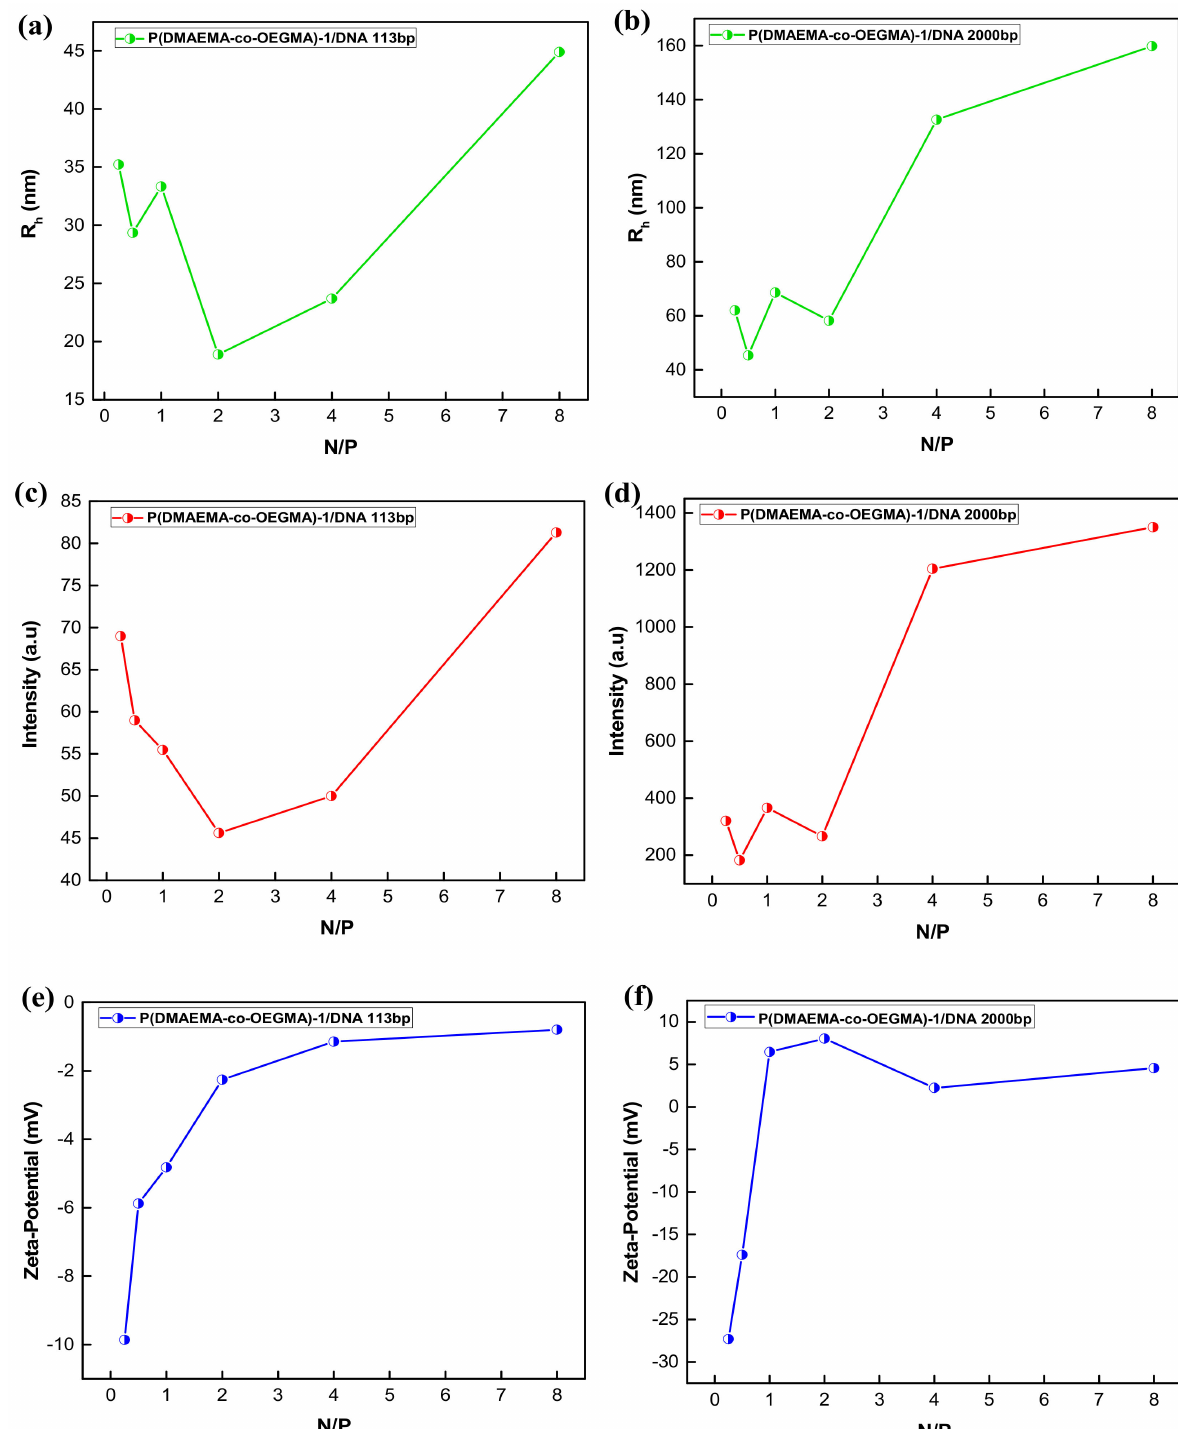
Figure 7. Variations of hydrodynamic radius (R h ) with the N/P ratio for ( a ) P(DMAEMA-co- OEGMA)-1/DNA 113 bp and ( b ) P(DMAEMA-co-OEGMA)-1/DNA 2000 bp polyplexes. Variations of scattered light intensity with the N/P ratio for ( c ) P(DMAEMA-co-OEGMA)-1/DNA 113 bp and ( d ) P(DMAEMA-co-OEGMA)-1/DNA 2000 bp polyplexes. Variations of zeta potential with the N/P ratio for ( e ) P(DMAEMA-co-OEGMA)-1/DNA 113 bp and ( f ) P(DMAEMA-co-OEGMA)-1/DNA 2000 bp